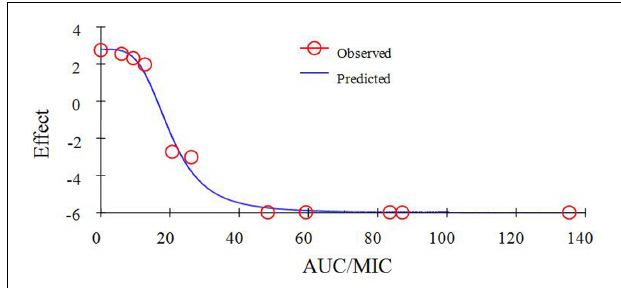
FIGURE 6 | Plots of ex vivo AUC/MIC ratios versus the amount difference of E. coli HB197 within 24 h.